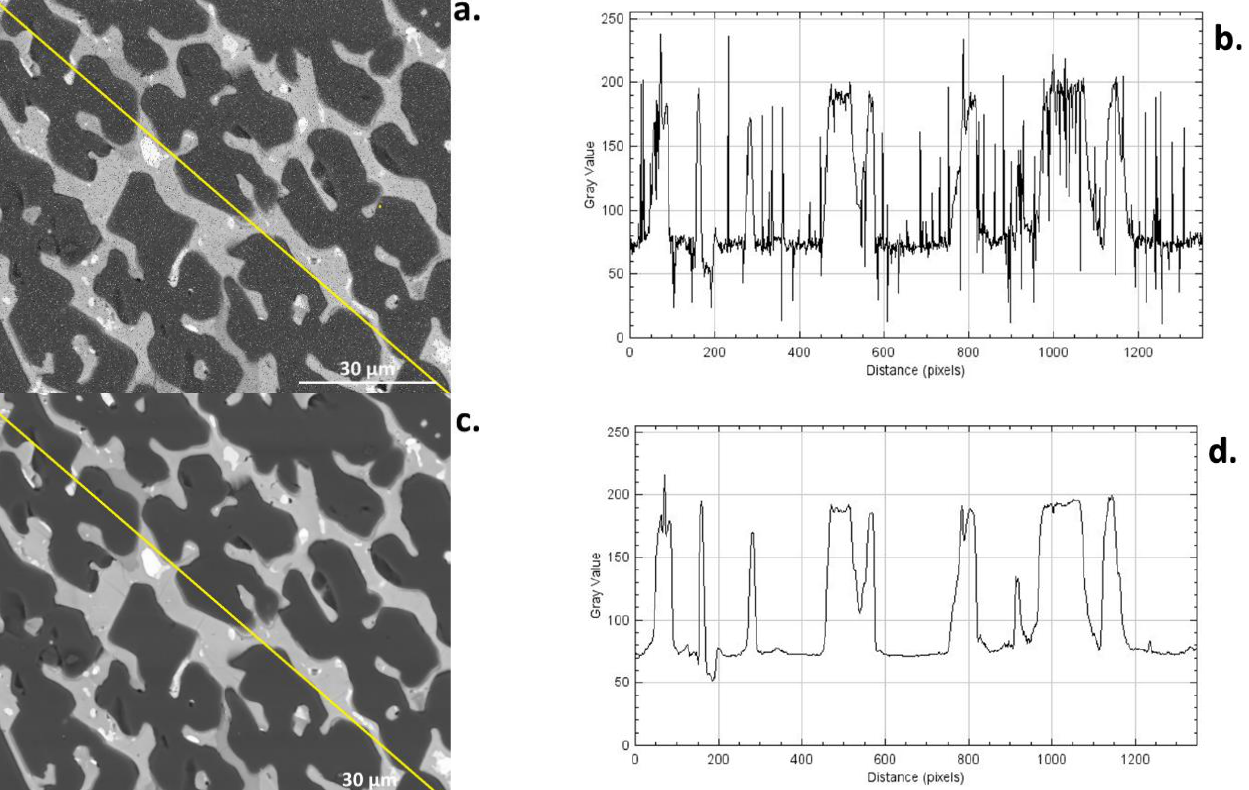
9 of 26 Figure 5. Comparison of the ( a ) input image with added noise, and images ( b ) after sharpening, ( c ) after noise removal, ( d ) with detected edges in the image without noise. Filters can help significantly in image preparation, e.g., if the image was registered with a signal. This can be evidenced by comparing the profile of the image with noise